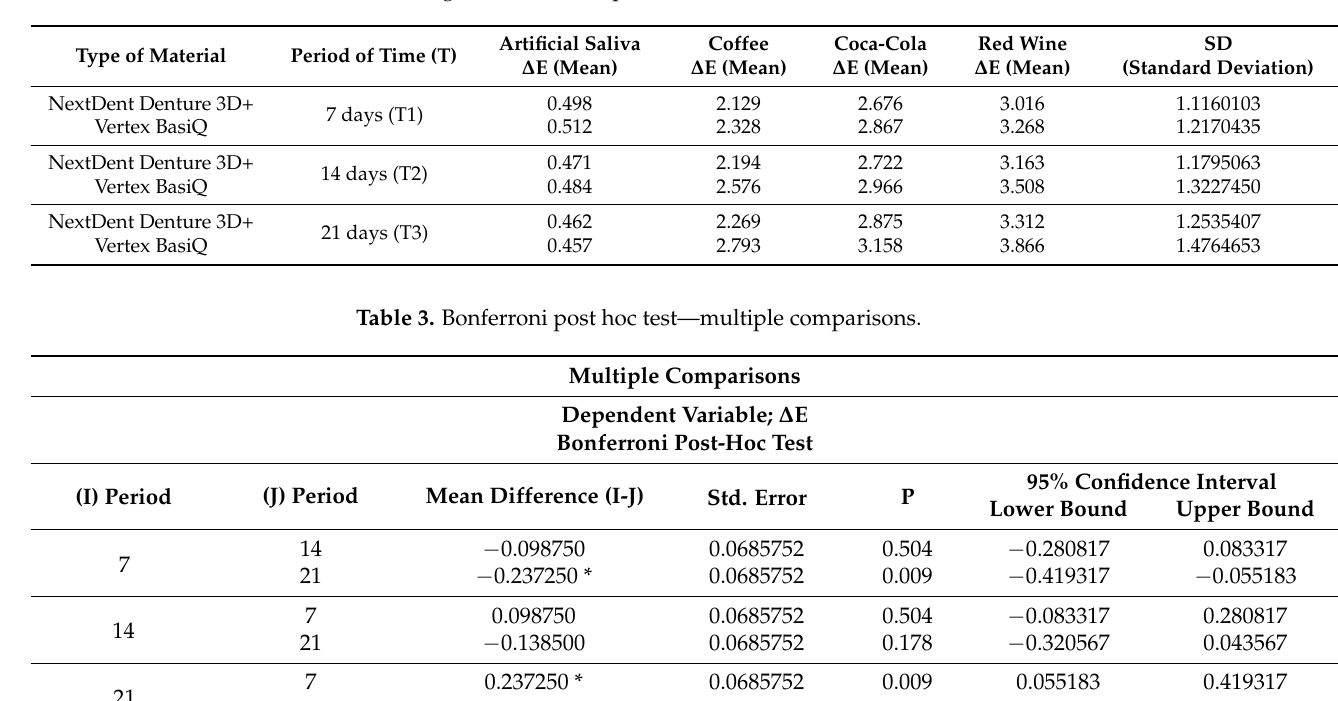
Table 2. Scheme of the experiment organization—colour change values of the selected materials according to the different periods of time.